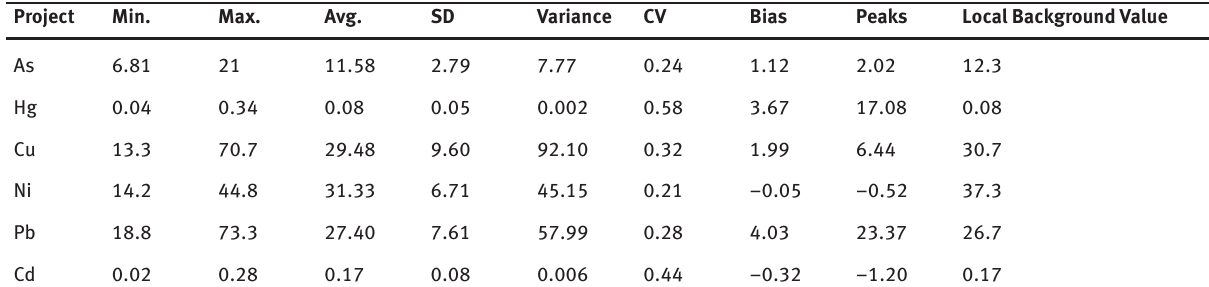
Table 2: Statistics of heavy metal concentration. Project Min.